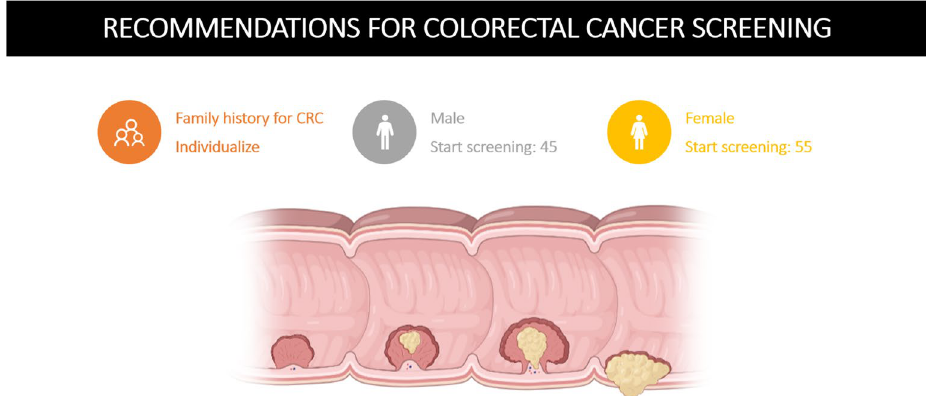
Figure 3. Age, sex and risk adjusted screening algorithm recommendation. CRC colorectal cancer; Created with